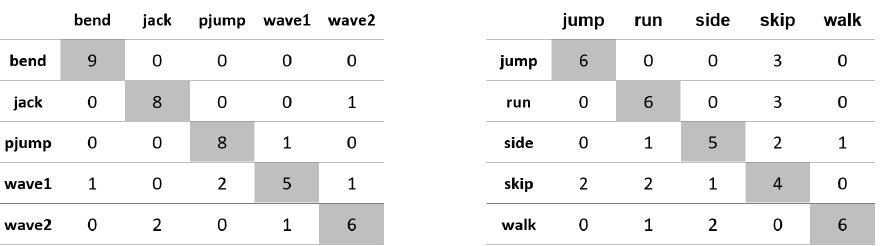
Figure A34. Confusion matrices for the experiment using the ‘upper-occlusion’ database, longerMBR and C1